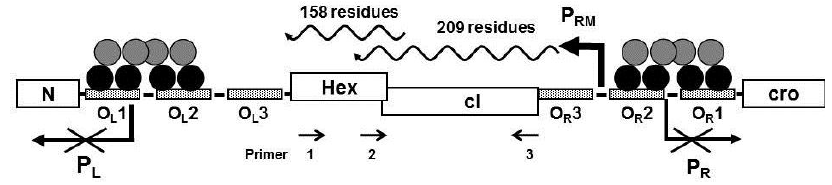
and P are repressed and transcription from P is R L RM . Primers RM transcript (see text). RM